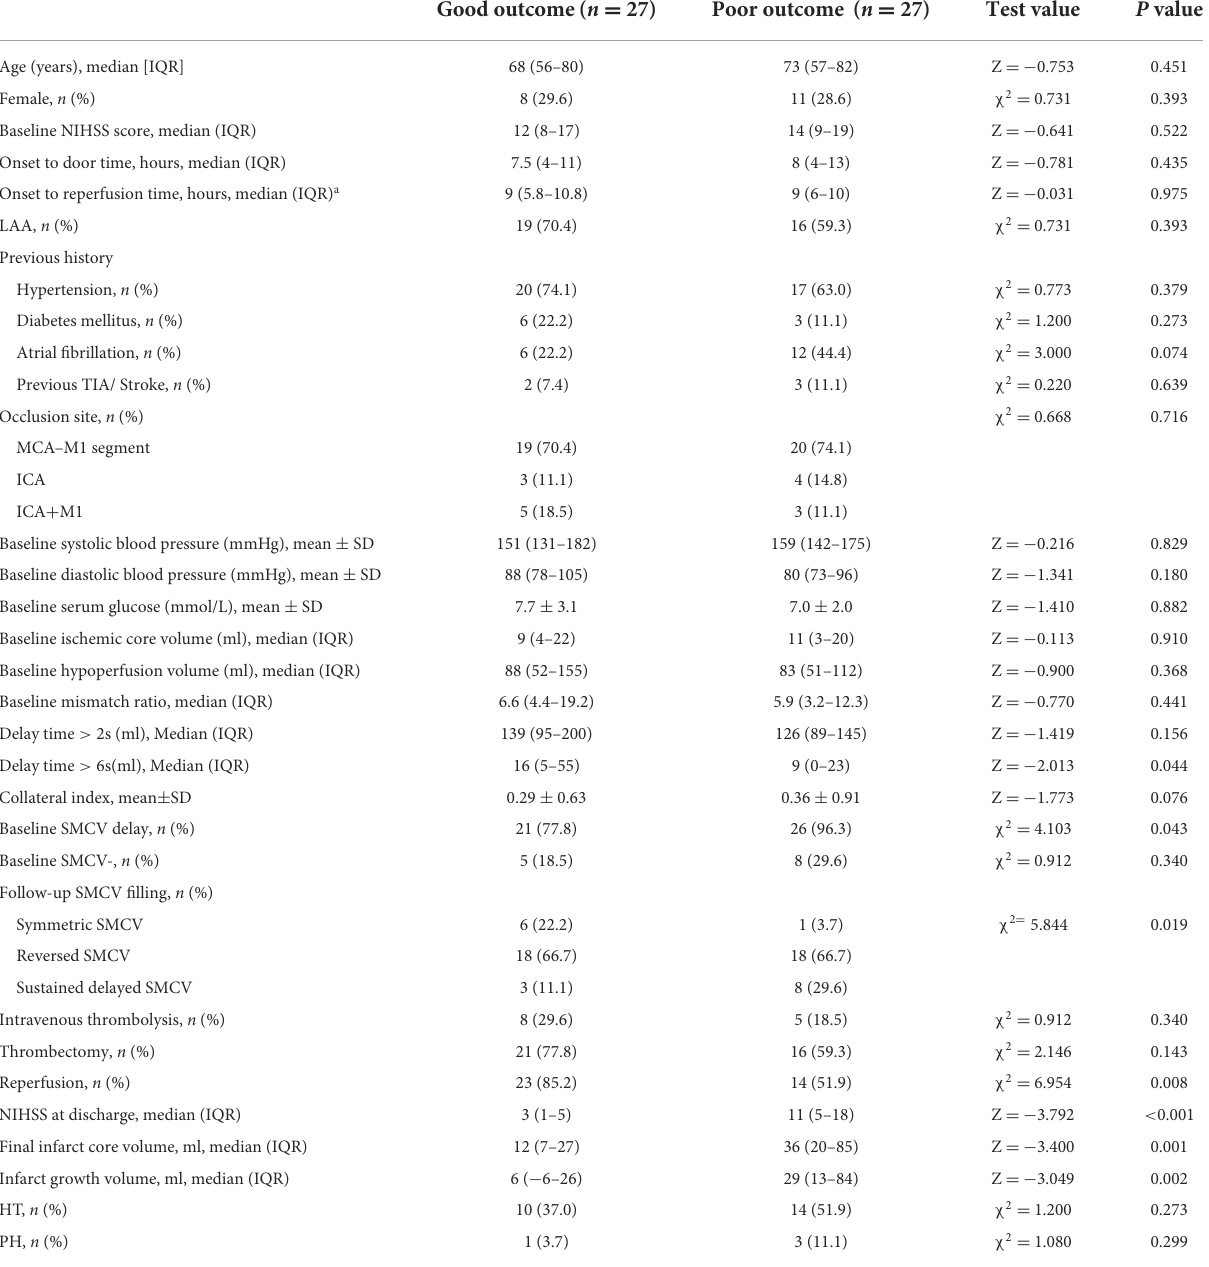
TABLE 2 Comparisons of baseline and follow-up characteristics between patients with a good and poor outcome at 3 months. Good outcome ( n = 27) Poor outcome ( n = 27) Test value P